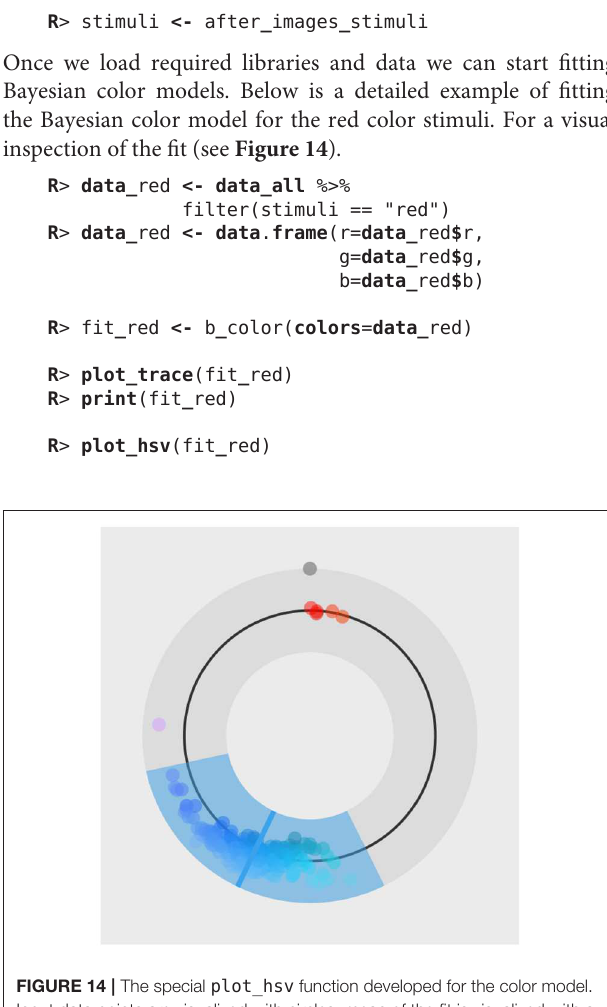
FIGURE 14 | The special plot_hsv function developed for the color model. Input data points are visualized with circles, mean of the fit is visualized with a solid line and the 95% HDI of the underlying distribution is visualized as a colored